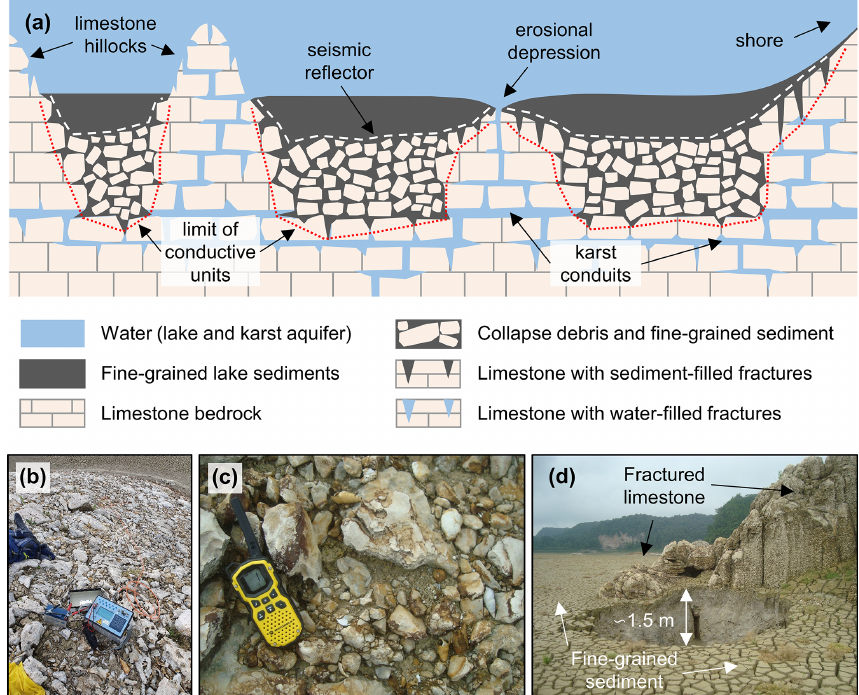
Figure 8. (a) Schematic sketch summarizing the geological conditions below Lake Metzabok interpreted from the geophysical survey (details not drawn to scale). The limit between the fine-grained lake sediments and the collapse debris with sediment-filled interspaces indicated by the white dashed line stands out as a strong reflector in all sub-bottom profiler images. All units containing fine-grained sediment are characterized by low electrical resistivity values; a strong resistivity increase marks the upper limit of the limestone bedrock as indicated by the red dotted line. Photographs show ( b and c ) limestone debris with fine-grained sediment as well as (d) fractured limestone and fine lake sediments exposed during the low-level stands in October 2019. Table 1. Ranges of physical properties of the geological units interpreted from our geophysical profiles and laboratory